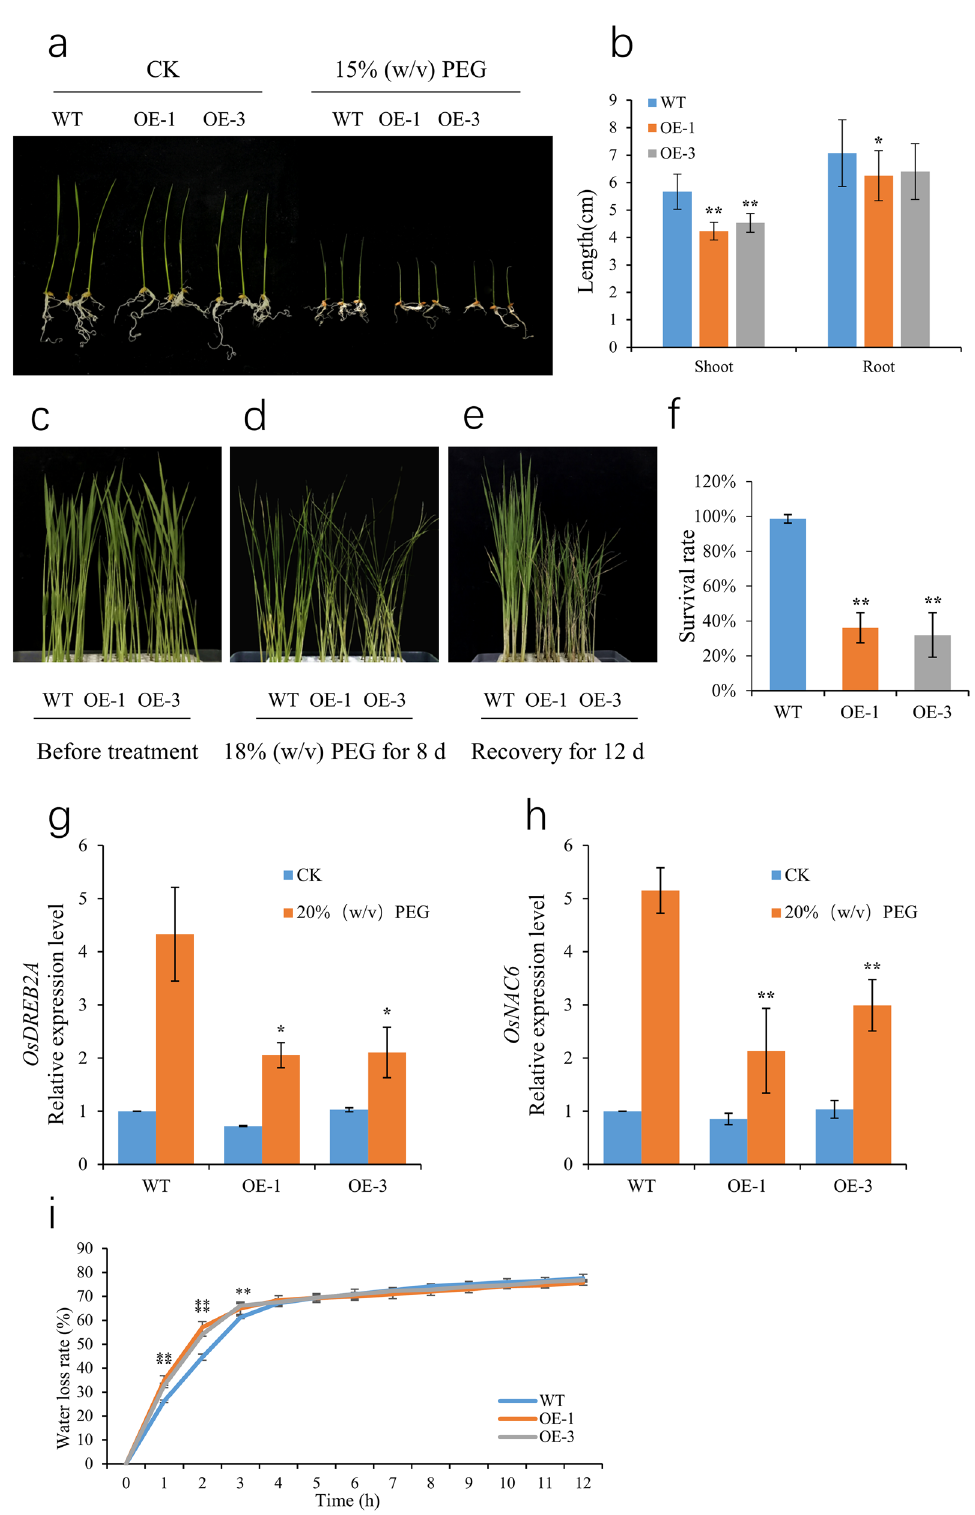
Figure 4. Effects of drought stress in wild type (WT) and OE lines. ( a ) Phenotypes of WT and OE lines under 15% w/v PEG for 3 days. ( b ) Plant height and root length of WT and OE lines treated at 15% w/v PEG for 3 days. ( c ) Phenotype of WT and OE lines hydroponically cultivated for 14 days (before imposition of the drought stress). ( d ) Phenotypes of WT and OE lines treated for 8 days at 18% w/v PEG. ( e ) Phenotypes of WT and OE lines after 12-day recovery following the 18% w/v PEG treatment. ( f ) Survival of recovered WT and OE lines. ( g – h ) The expression levels of OsDREB2A and OsNAC6 were analyzed after two days of treatment at 20% w/v PEG, respectively. ( i ) Water loss rates of detached leaves from 14-day-old plants. Error bars represent ± SE (n = 3). Asterisks indicate significant differences between transgenic lines and WT ( * P < 0.05, ** P <